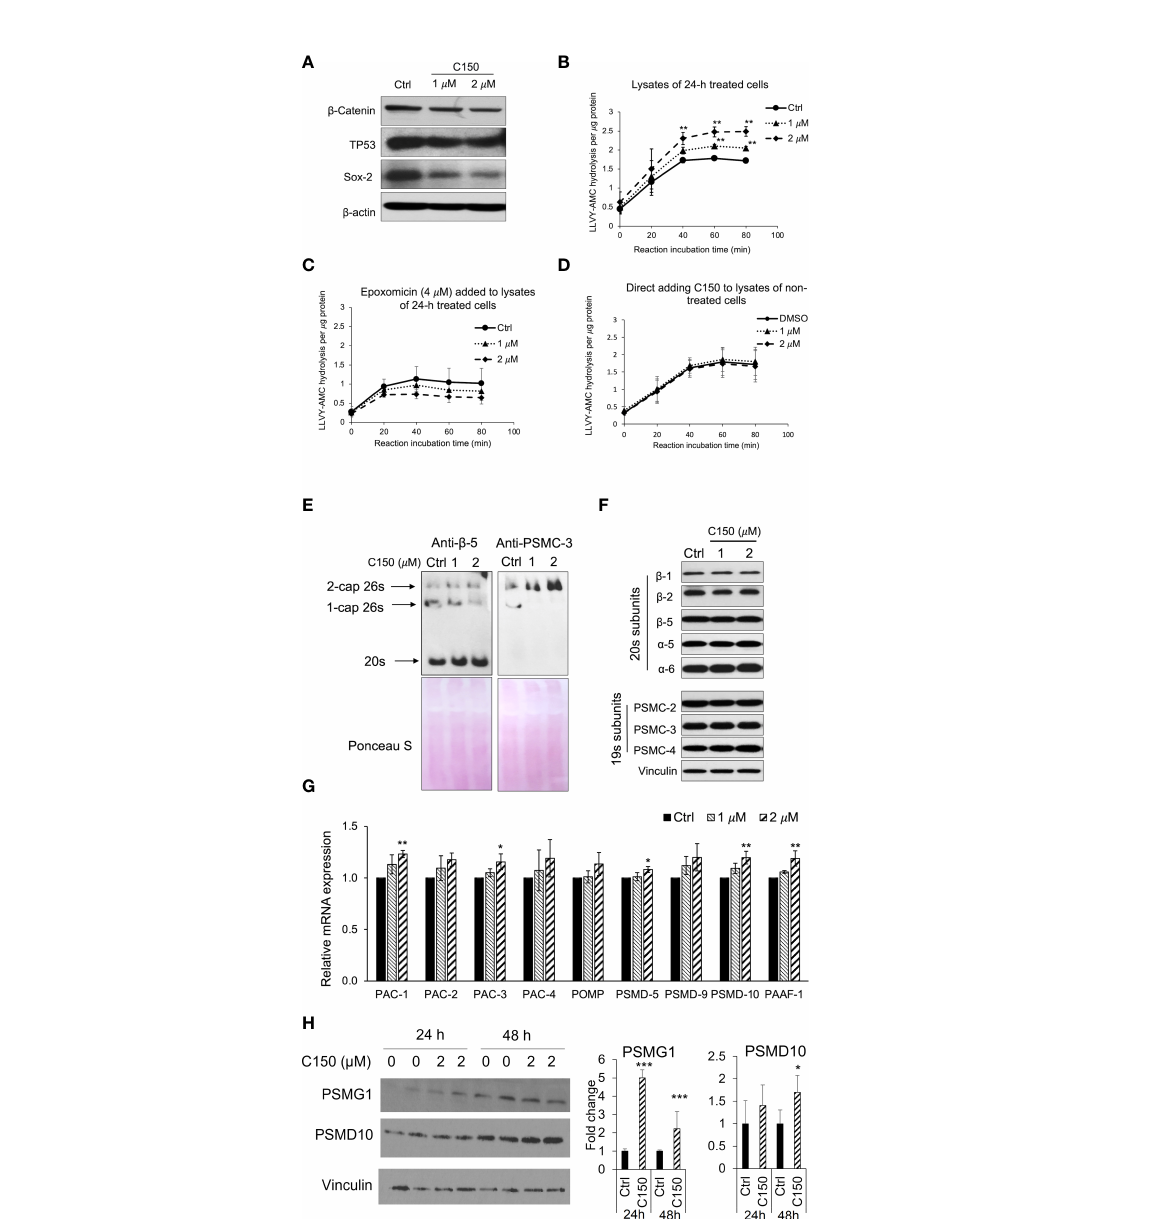
FIGURE 1 C150 enhanced proteasome activity by increasing 20s proteasome and 26s proteasome assembly. (A) C150 decreased b -catenin, TP53, and Sox-2 protein level. PANC-1 cells were treated with DMSO (Ctrl) or C150 (1 m M and 2 m M) for 24 h. Total cell lysate was analyzed. b -Actin was blotted as loading control. (B, C) Proteasome activity in PANC-1 cells treated with C150. PANC-1 cells were treated with C150 (1 m M and 2 m M) or DMSO (Ctrl) for 24 h. Cell lysates were collected and incubated with proteasome substrate Suc-LLVY-AMC at 37°C, in the absence (B) and presence (C) of epoxomicin (4 m M), and the kinetics of fl uorescence signal was detected every 20 min for 80 min at 360/460 nm. Fluorescence signal intensity was quanti fi ed to the protein amounts in each reaction. (D) Proteasome activity in PANC-1 cell lysate incubated with C150. DMSO (Ctrl) or C150 (1 m M and 2 m M) was directly added into lysates of non-treated PANC-1 cells and incubated at room temperature for 30 min before mixing with Suc-LLVY-AMC substrate. (E) Native gel blots for assembled 20s and 26s proteasome. Anti b-5 antibody was used to show the 20s and anti-PSMC-3 was used to show the 26s proteasomes. Lower panels show Ponceau S staining. (F) Western blots of proteasome subunits. PANC-1 cells were treated with C150 (1 m M and 2 m M) or DMSO (Ctrl) for 24 h. Total cell lysates were used. Vinculin was a loading control. (G) RT-qPCR for mRNA expressions of proteasome assembly chaperones. PANC-1 cells were treated with C150 (1 m M and 2 m M) or DMSO (Ctrl) for 24 h. Results were quanti fi ed and normalized to Ctrl group using the 2 − DD Ct method with GAPDH as a housekeeping gene. (H) Western blots of PSMG-1 ( PAC-1 gene product) and PSMD-10 proteins. The left panel is a representative image of the Western blots. The right panel shows fold changes of relative bands intensity normalized to Vinculin. All data are presented as mean ± SD of three independent experiments. * p < 0.05, ** p < 0.01 , ***p < 0.001 (vs. Ctrl) by either Student ’ s t -tests between two groups, or one-way ANOVA with Tukey HSD tests among multiple